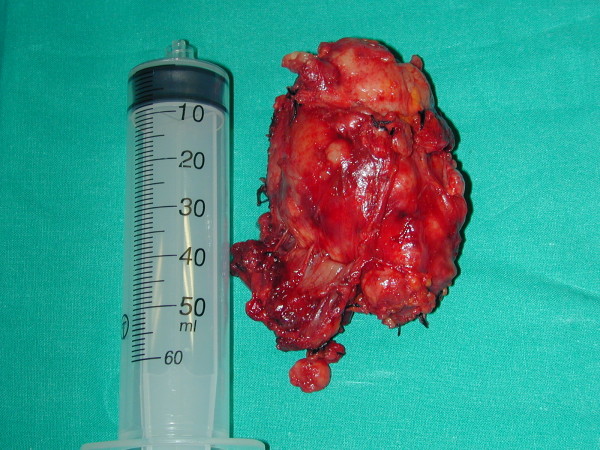
Total thyroidectomy.